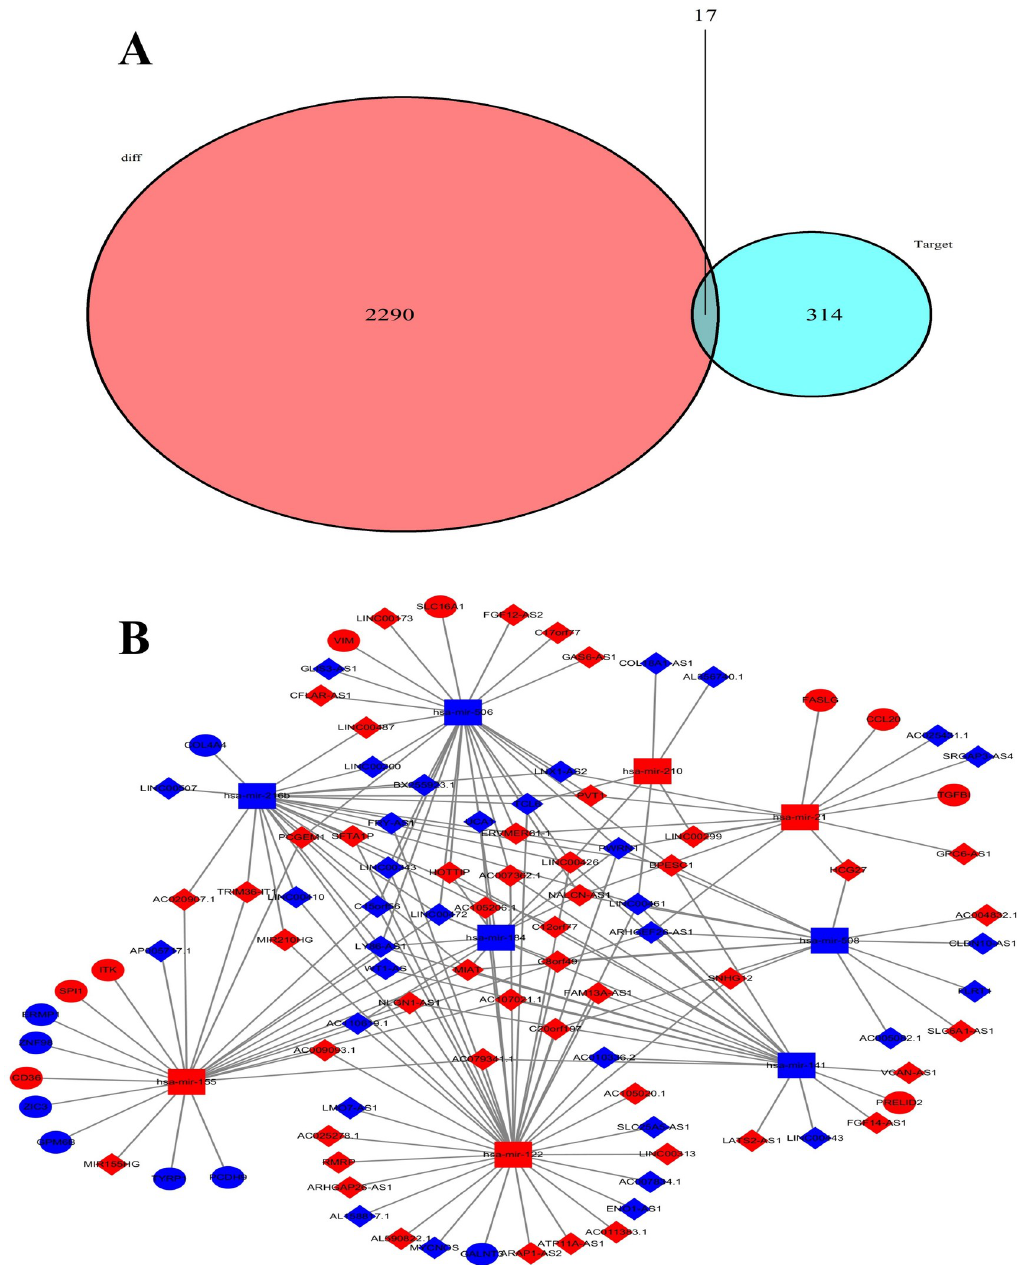
Fig 2. Venn diagram of mRNA and ceRNA networks in KIRC. (a) The intersection of the DEmRNAs and the target mRNAs constituted the Venn diagram. (b) The ceRNA network was composed of DElncRNA, DEmiRNA, and DEmRNA. The diamond was lncRNA, the rectangle was miRNA, and the ellipse was mRNA. Red indicated upregulation, and blue indicated